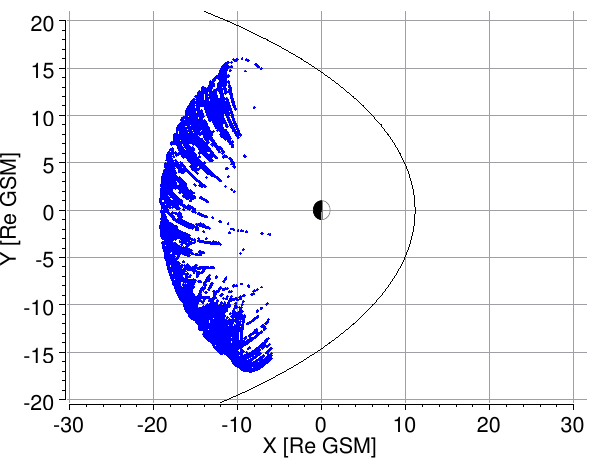
Fig. 1. Spatial coverage of the data set. The majority of the mea- surements are obtained near Cluster’s apogee at 18 R E , and within local times ’